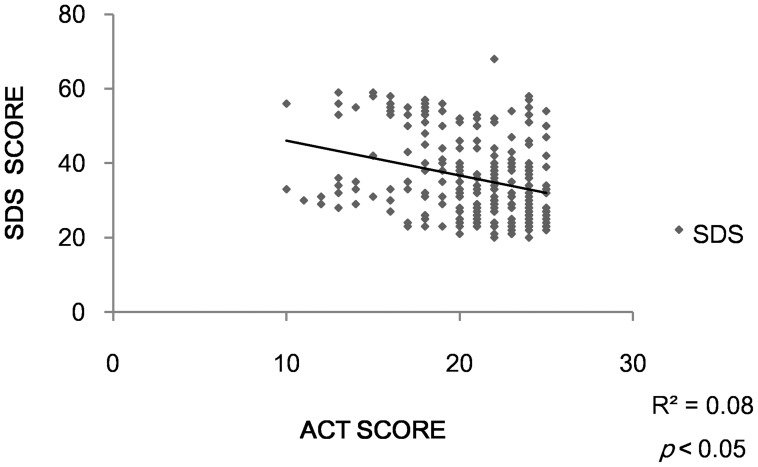
Correlation between ACT and SDS.